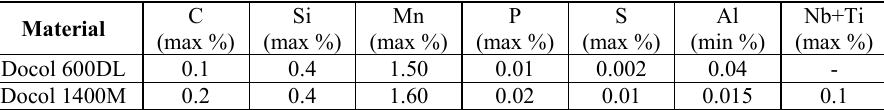
Table 1. Chemical composition of Docol 600DL and Docol 1400M (in wt.%) [5].